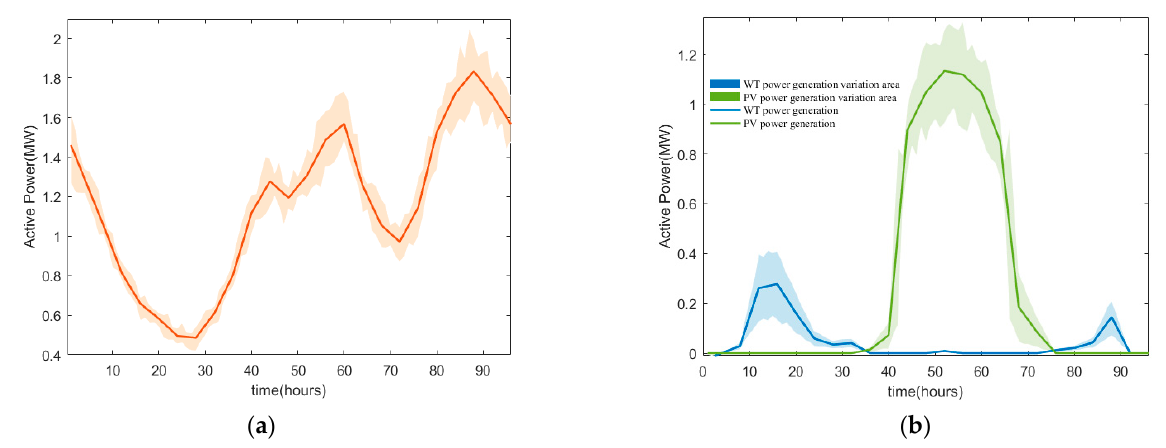
Figure 9. ( a ) ADN load consumption. ( b ) WT and PV power production and their variation areas.